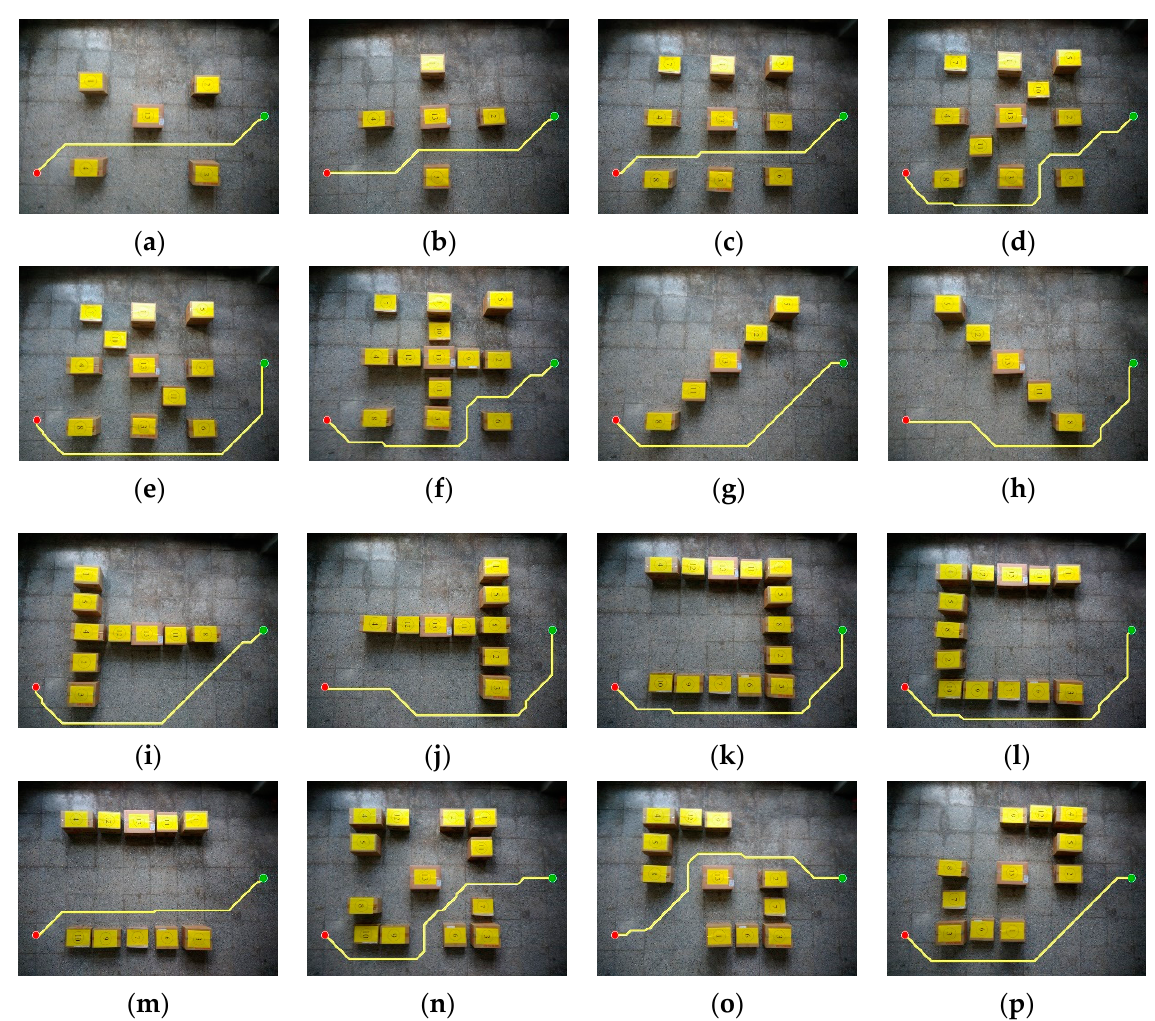
Figure 27. Planned paths shown in Experiment VIII: ( a ) result #1; ( b ) result #2; ( c ) result #3; ( d ) result